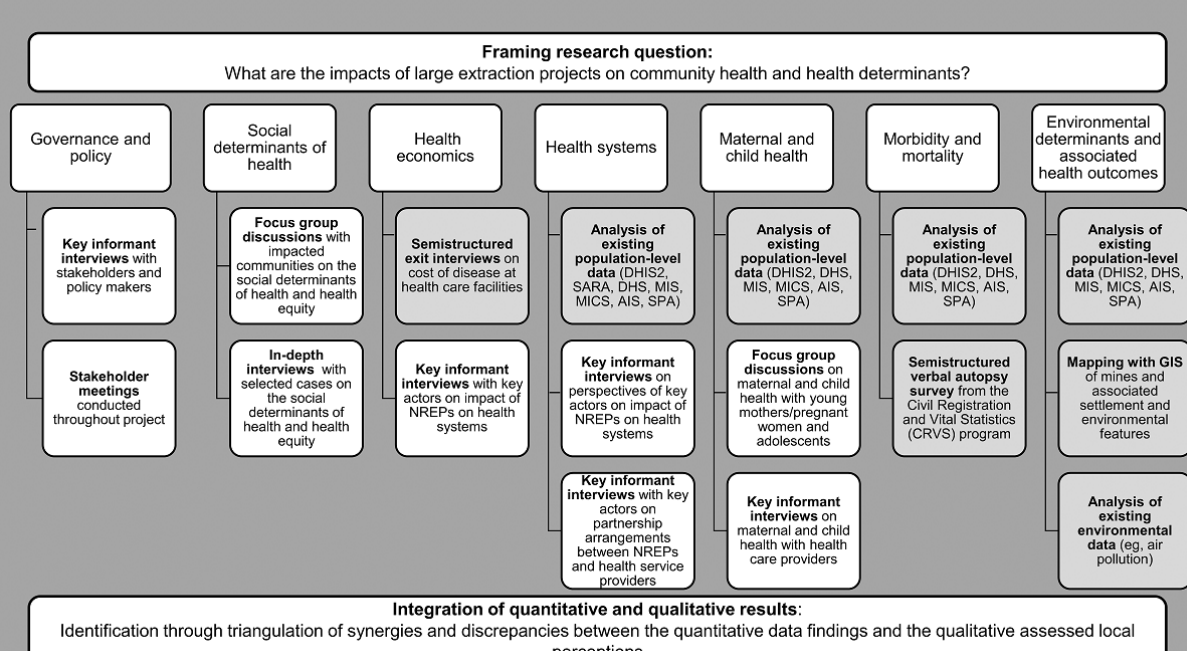
Figure 1. Study design. The headings are the research topics relevant to population health in natural resource extraction project (NREP) areas identified in conjunction with local partners. The specific research topics are investigated with both qualitative (white) and quantitative (gray) research methods. AIS: AIDS Indicator Survey; DHIS2: District Health Information System 2; DHS: Demographic and Health Survey; GIS: geographic information system; MICS: Multi-Indicator Cluster Survey; MIS: Malaria Indicator Survey; SARA: Service Availability and Readiness Assessment; SPA: Service Provision Assessment.